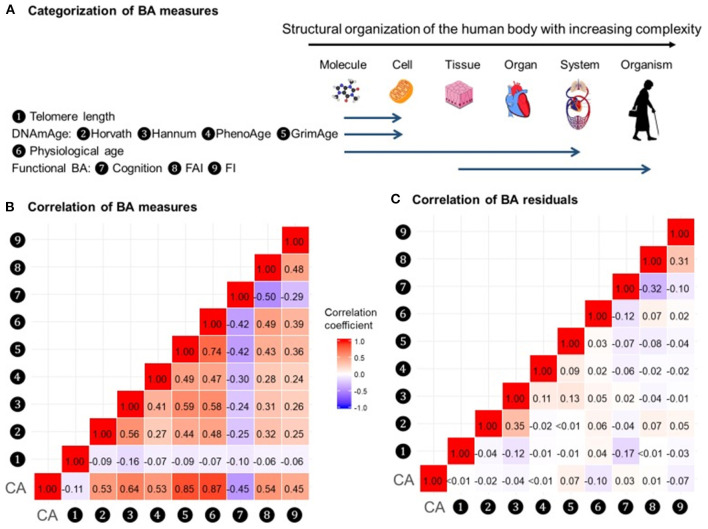
Correlations of BAs in 288 individuals (612 complete measurements). A total of 612 complete measurements assessed from 288 individuals were included to estimate the correlations of BAs. BAs were broadly categorized into four groups according to the main biological structural levels where the BA measurements were implemented (A). We estimated the repeated-measure correlation coefficients between BAs and between BA residuals and illustrated the correlation coefficients in heat maps (B,C). Red and blue tiles represented positive and negative correlations, respectively; color density indicated the magnitude of correlation coefficients. All BAs were correlated to varying degrees (B). After regressing out CA from BAs, most of the original correlations were attenuated (C). BA, biological age; DNAmAge, DNA methylation age estimator; FAI, functional aging index; FI, frailty index; CA, chronological age. The figure and its legend are reproduced from the article by Li et al. (2020) distributed under the terms of the Creative Commons Attribution License. Copyright © 2020, Li et al.